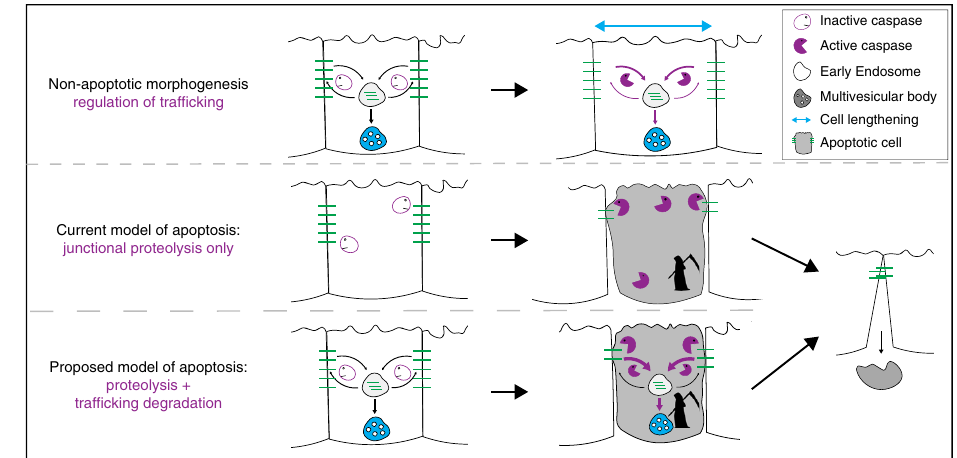
Fig. 5 Model for caspase-regulated endocytic traf fi cking in apoptosis. See main text for